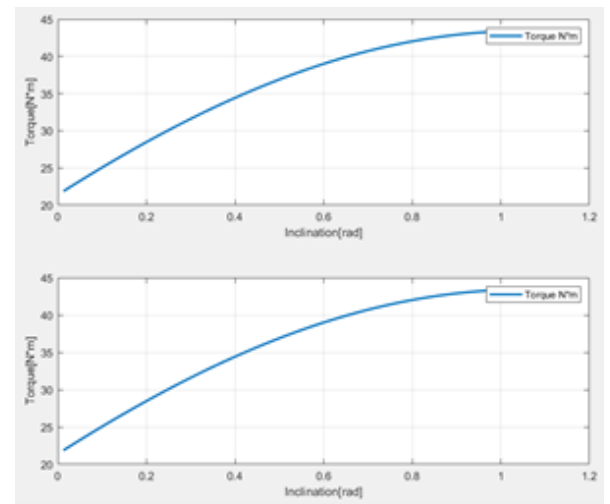
over time. The torque reflects the congruence with the kine- matic equations, although the dynamic equation rejects the external